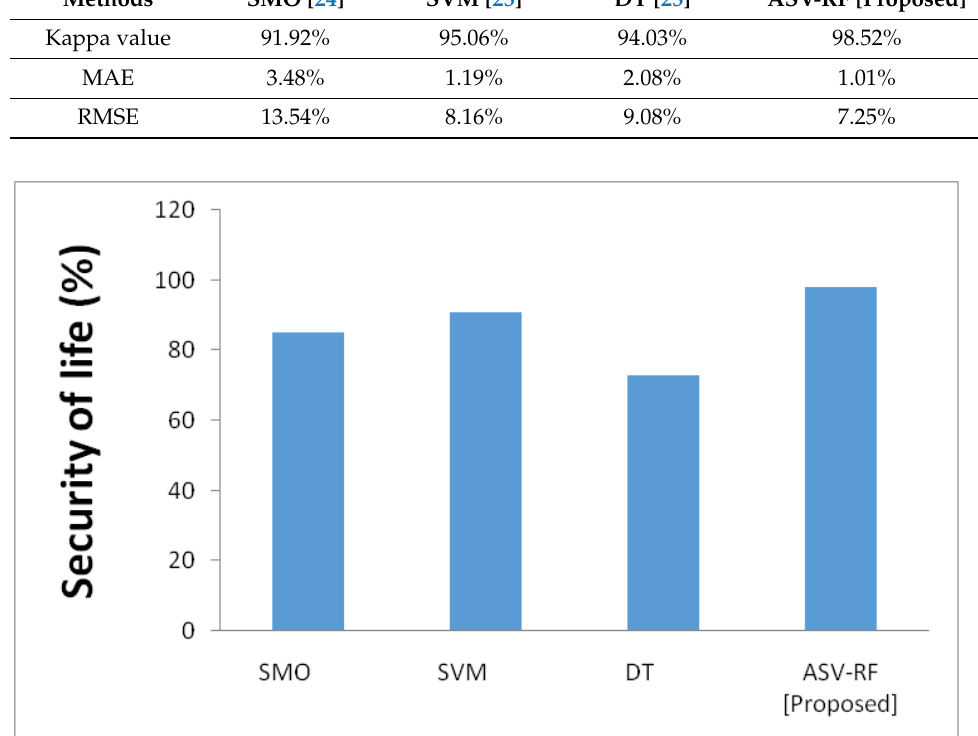
Figure 7. Results of security of